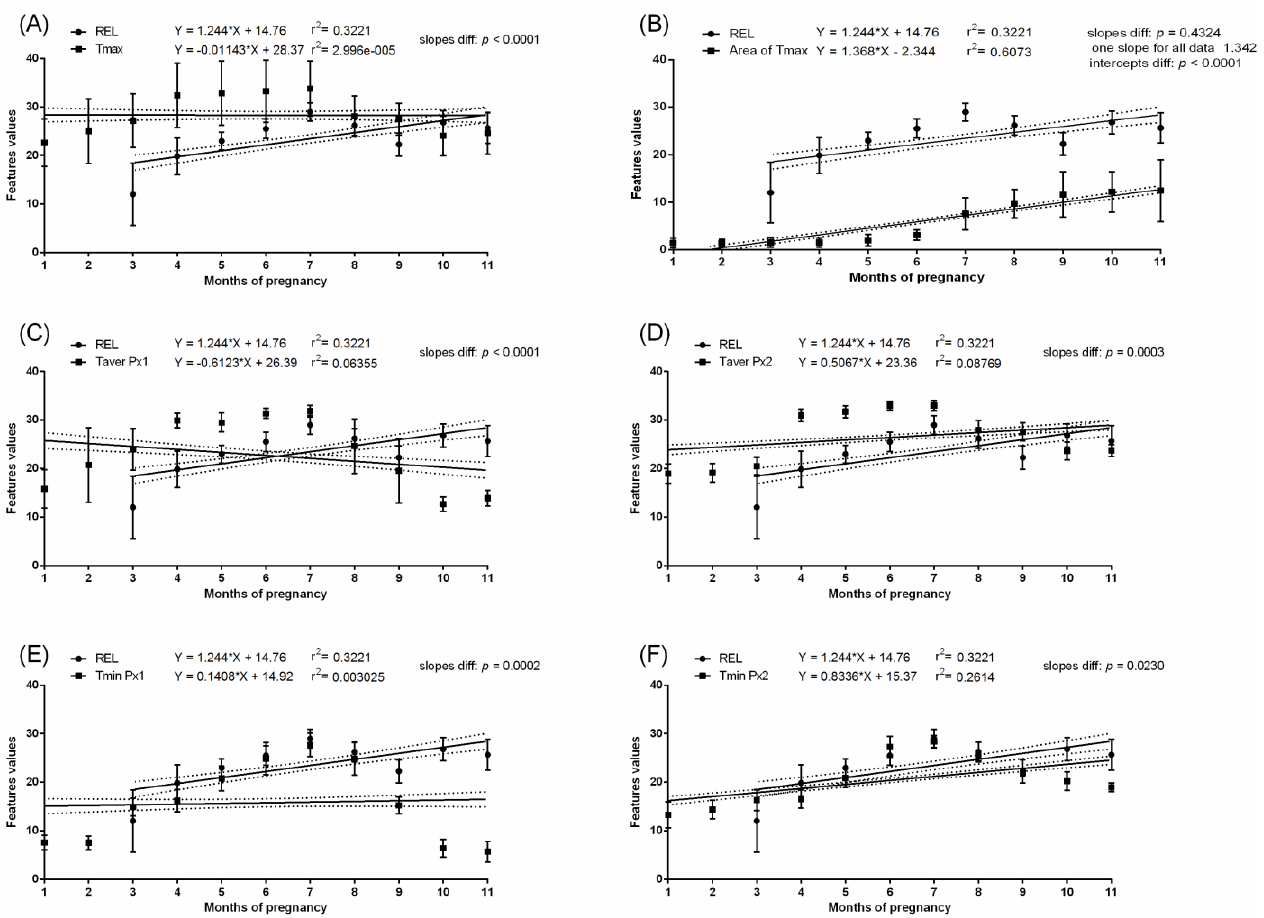
Figure 8. Linear regressions of relaxin concentration in the serum and selected thermal features of the lateral surface of the abdomen in pregnant mares: the maximal temperature in Px1 and Px2 ( A ); the area with the highest temperatures in the range of 3 °C ( B ); the average temperature in Px1 ( C ); the average temperature in Px2 ( D ); the minimal temperature in Px1 ( E ); the minimal temperature in Px2 ( F ).